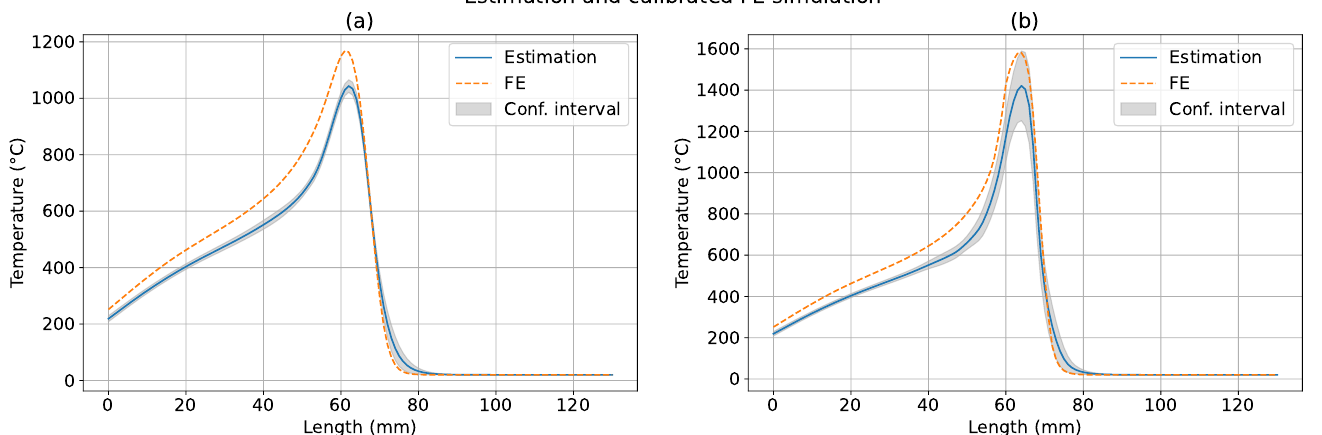
Figure 12. Temperature estimations obtained from infrared experimental data, FE simulation and confidence interval. ( a ) Camera side. ( b ) Torch side.